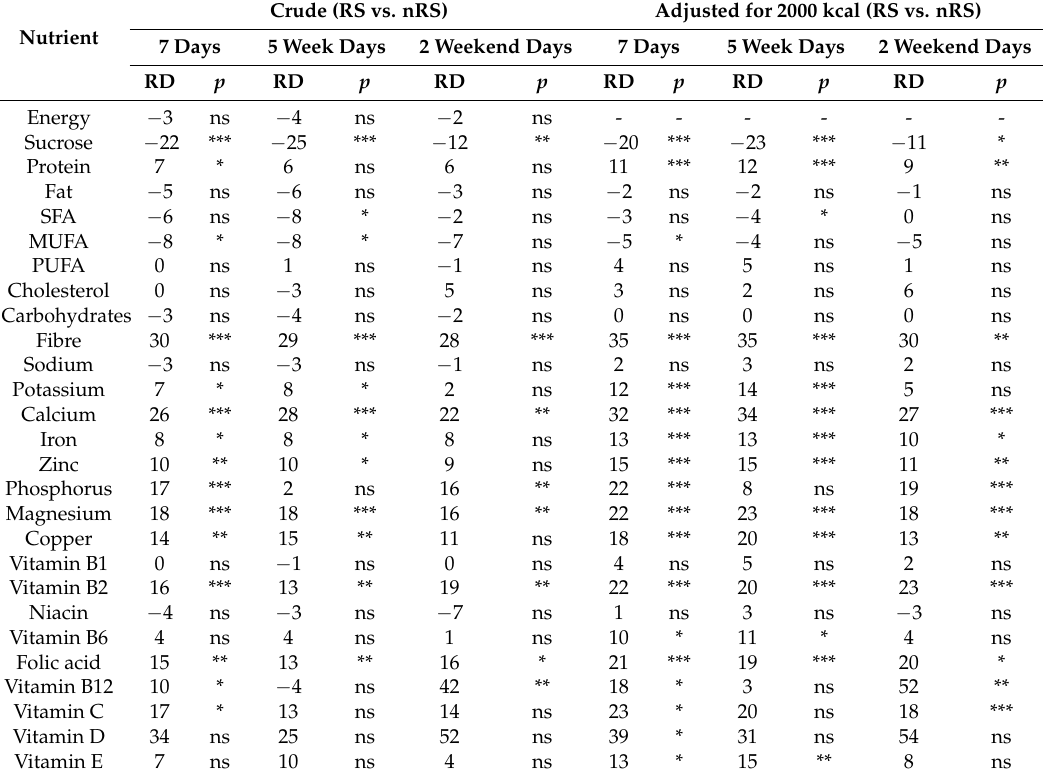
Table 3. Relative differences (RD, in %) in mean daily dietary intakes between women “restricting sugar” (RS) and “not restricting sugar” (nRS) over seven days, including five weekdays and two weekend days, with crude and adjusted